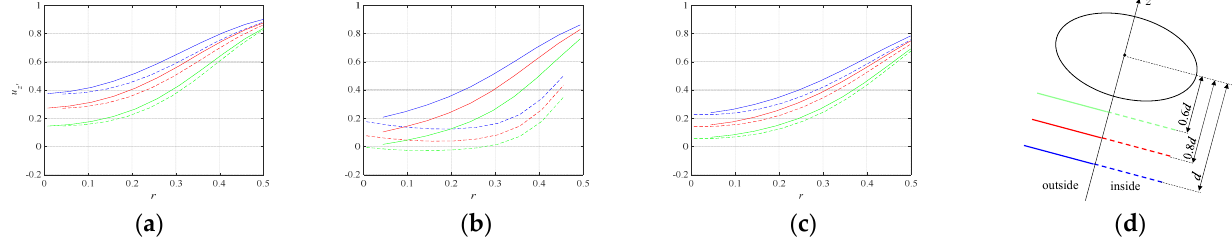
Figure 12. Streamwise velocity behind bubble: ( a – c ) are under same conditions as in Figure 8. ( d ) Legend description for ( a – c ). Solid line: outside velocity. Dashed line: inside velocity. Green lines indicate 0.6 d behind center of bubble, red ones 0.8 d , and blue ones 1 d .